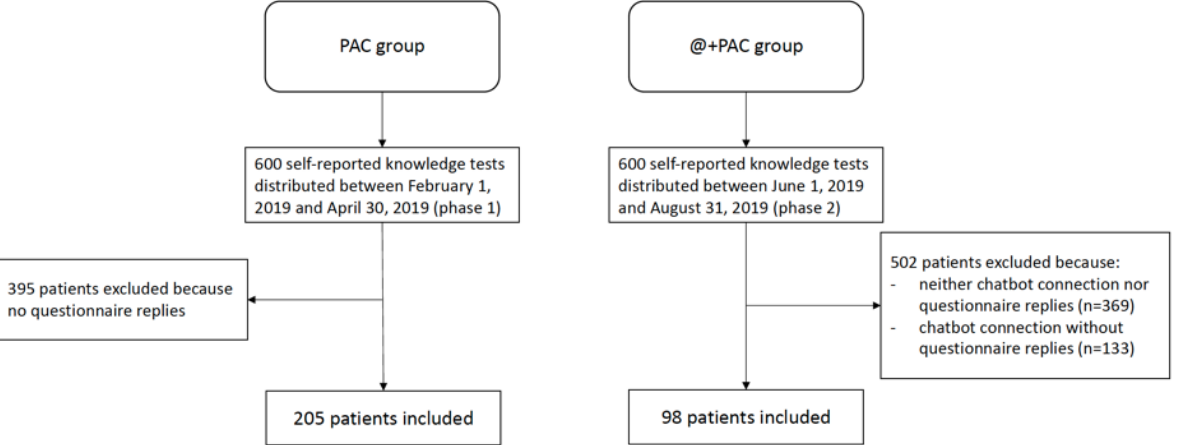
Figure 3. Flow chart of patient selection. PAC: preanesthetic consultation; @+PAC: digital conversational agent and preanesthetic consultation.